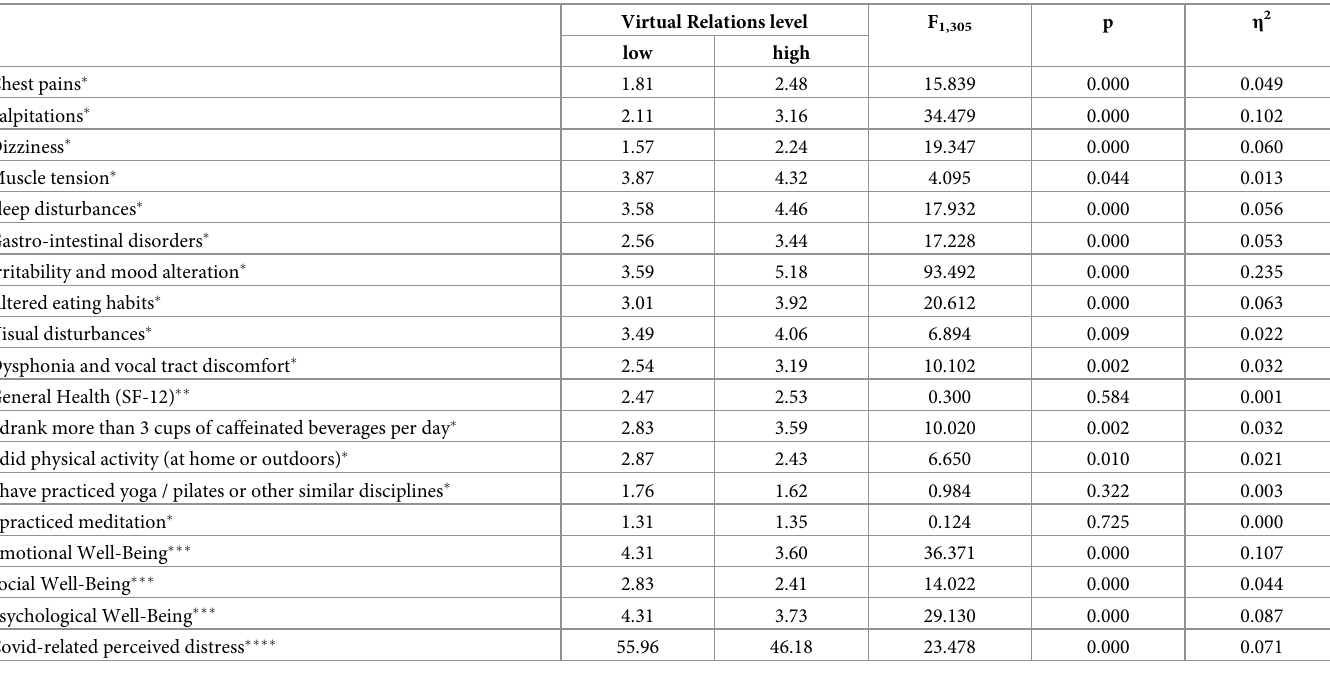
Table 10. Results of Anova–Virtual relations fatigue levels and